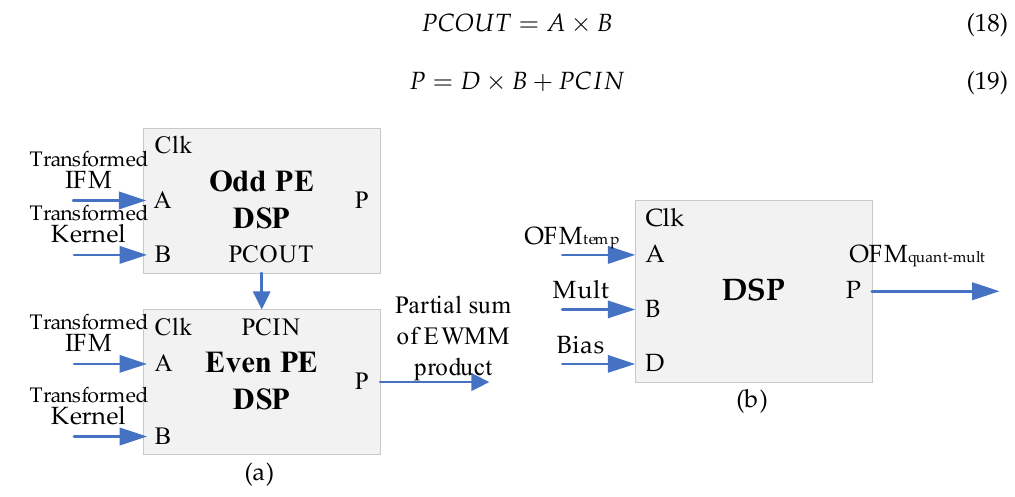
Figure 6. Multi-Mode DSP ( a ) DSP of PE. ( b ) DSP of Acc. & Quant. Multiply module.